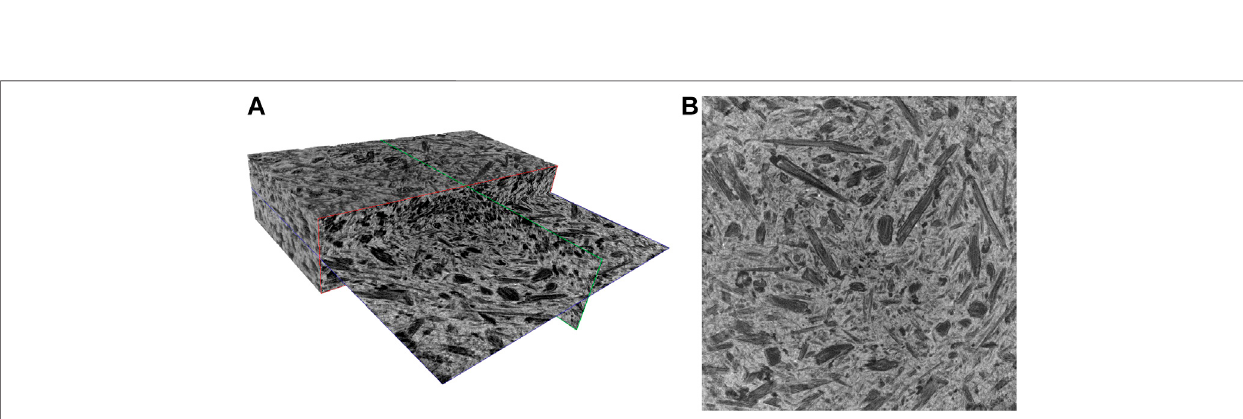
FIGURE 1 | SEM micrographs (800 × ) of pyrolized chippings of A. Donax L. before crushing (A) and after crushing (B) . Arrows indicated the preserved structure of the cellulosic vegetal wall.